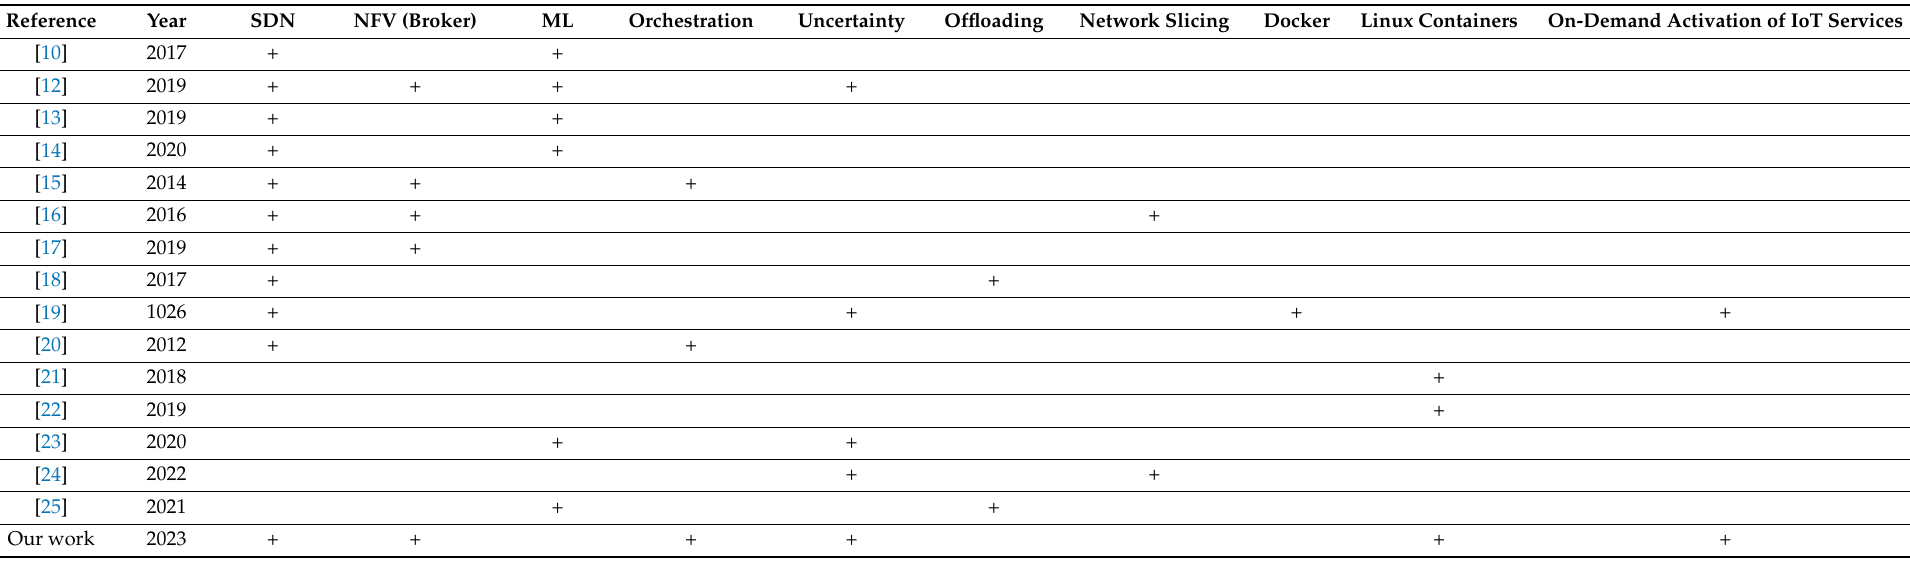
Table 1. Literature comparison of covered topics, marked by